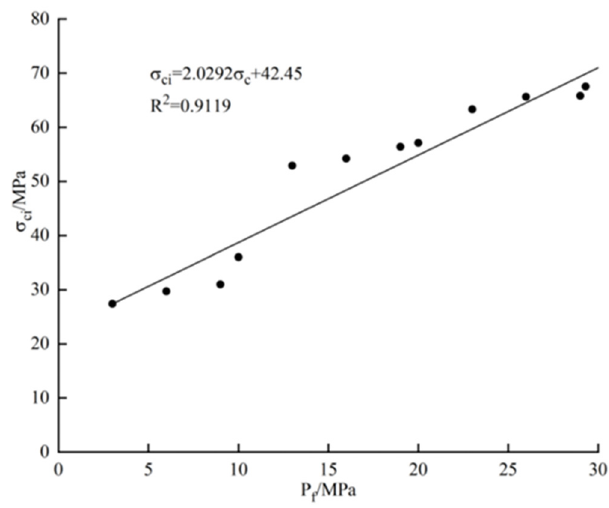
Figure 5. Relationship between the crack initiation stress and effective confining pressure.